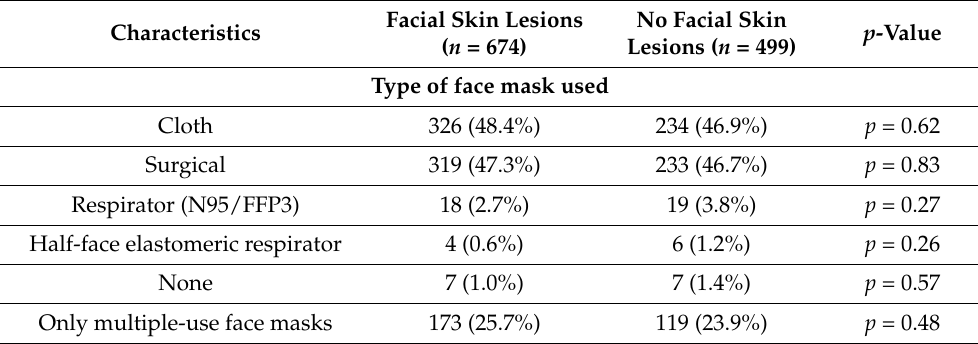
Table 4. The influence of facial skin lesions on the type of face mask used and other face mask-related behaviors. The values in bold are considered statistically